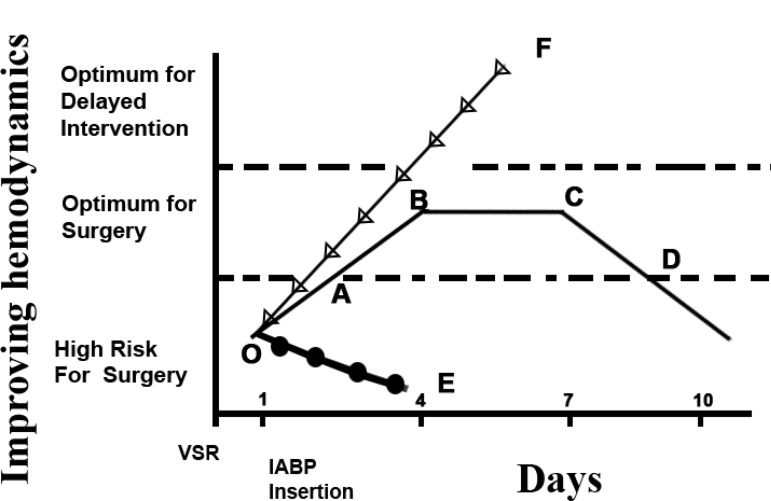
Hemodynamic patterns after IABP institution and suggested timing of
intervention.Group 1 (OE Segment, n=18): Patients who were not improving
hemodynamically, even after IABP, high inotropic supports and
ventilatory support, represented a true surgical emergency and
needed Immediate Surgery.Group 2 (OF Segment, n=5): Few patients who were stable, with no
clinical deterioration, underwent Elective Repair/Percutaneous
Closure after 4-6 weeks.Group 3 (OD Segment, n=22): In this category, patients usually
improved hemodynamically with institution of IABP, inotropic
support, and with/without ventilatory support. The improvement
brought them to lower Killip Class (Segment AB), which plateaued
afterwards (Segment BC). After this phase, deterioration started
(Segment CD) by virtue of infection and vascular complications. This
period (Segment BC), in which patient’s condition was optimum, was
the window of opportunity for the surgeon. (Optimal Delay)